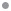
Trends in experimental vs. prediction solubilities of CO2.(x) Experimental solubility data of CO2, (●) COSMO-RS predicted data. Error bars represent the typical 5% error.